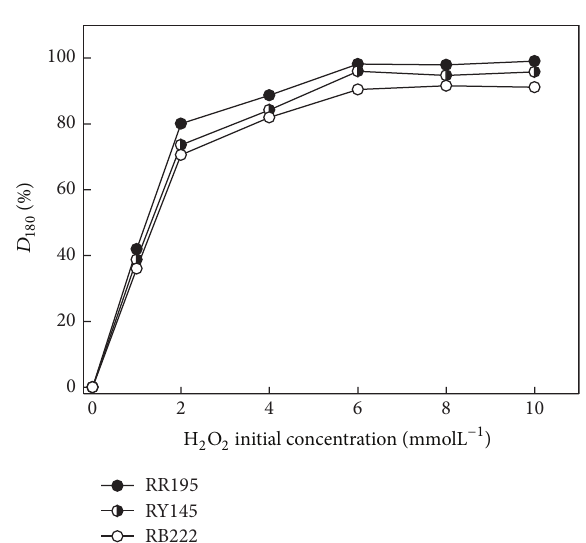
Figure 2: Degradation of three dyes with varied initial concentra- tion of H 2 O 2